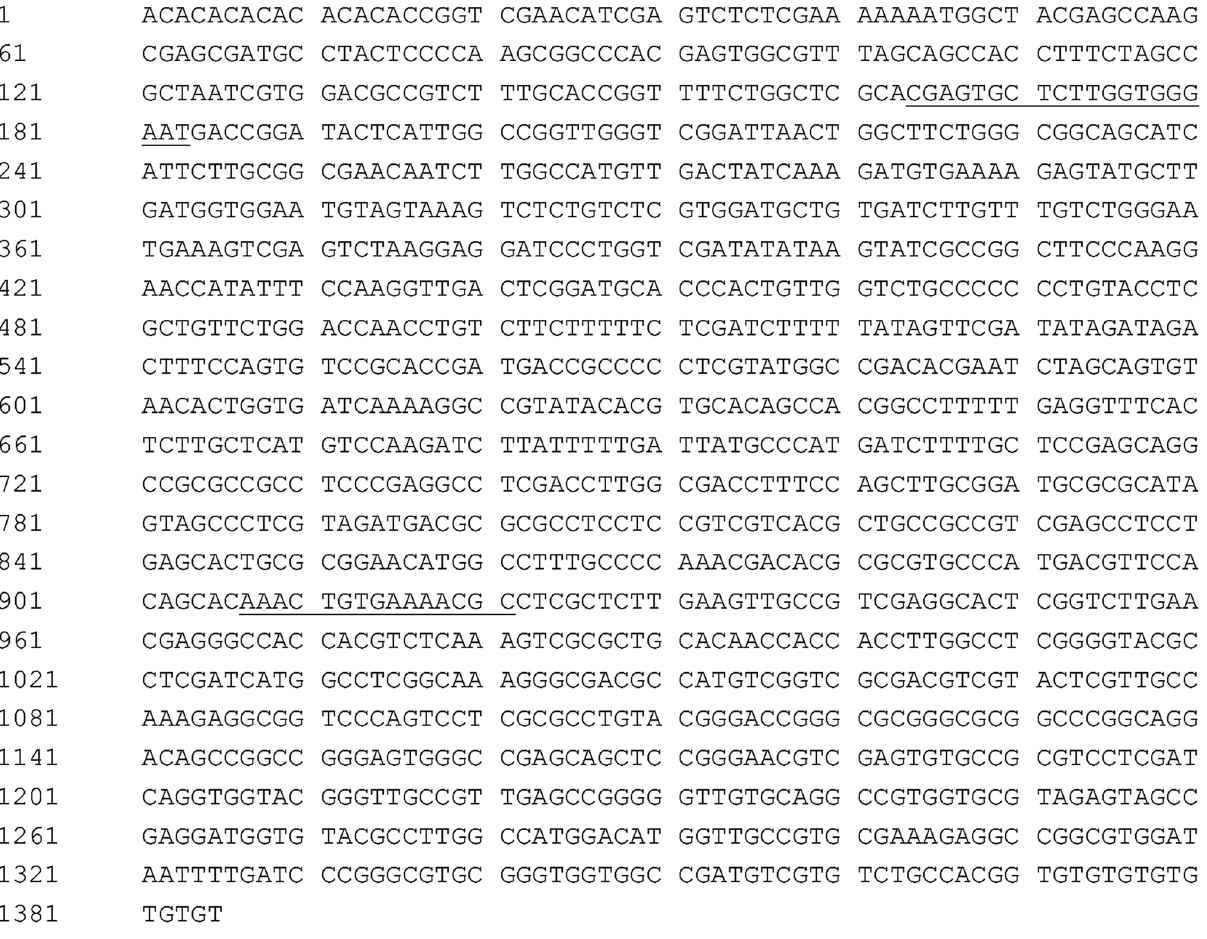
Figure 2. Sequence of a specific DNA fragment of Tilletia laevis . The sequence used for the amplification primers (L57F and L57R) is